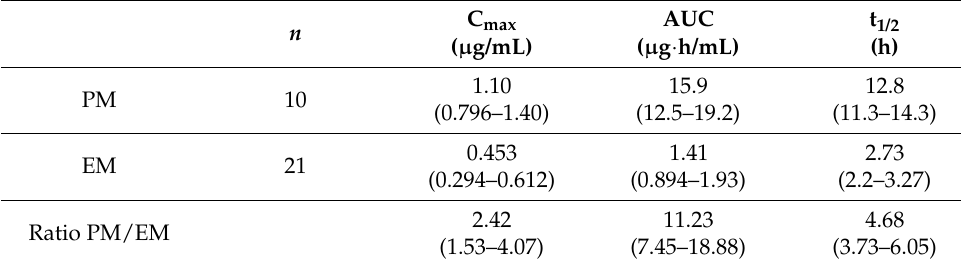
Table 3. Pooled analysis of propafenone pharmacokinetics stratified by CYP2D6 phenotype at a